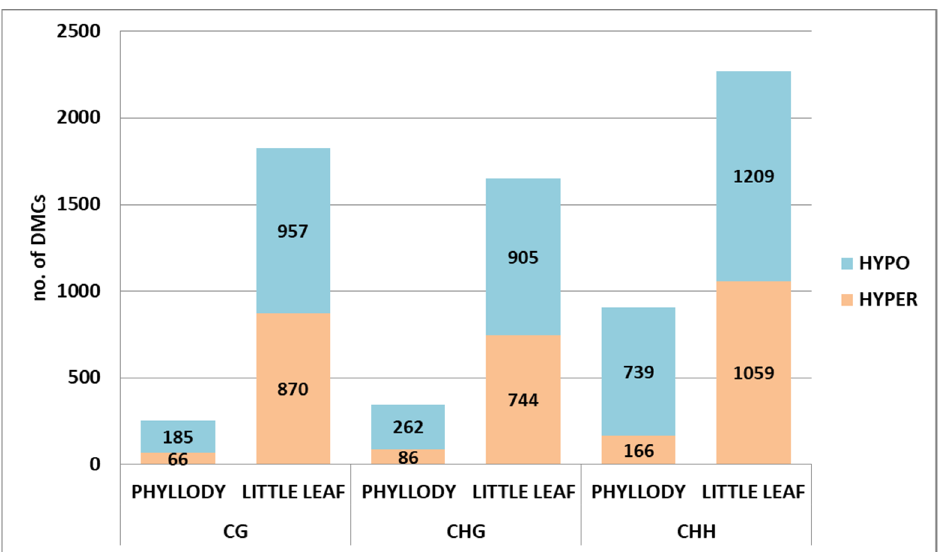
Figure 7. Number of Hyper- and hypomethylated Differentially Methylated Cytosines (DMCs) with percent methylation of >25% in phyllody (I1) and little leaf (LL)-affected sesame in comparison to healthy flowering (HF) and healthy vegetative (H1) sesame, respectively.